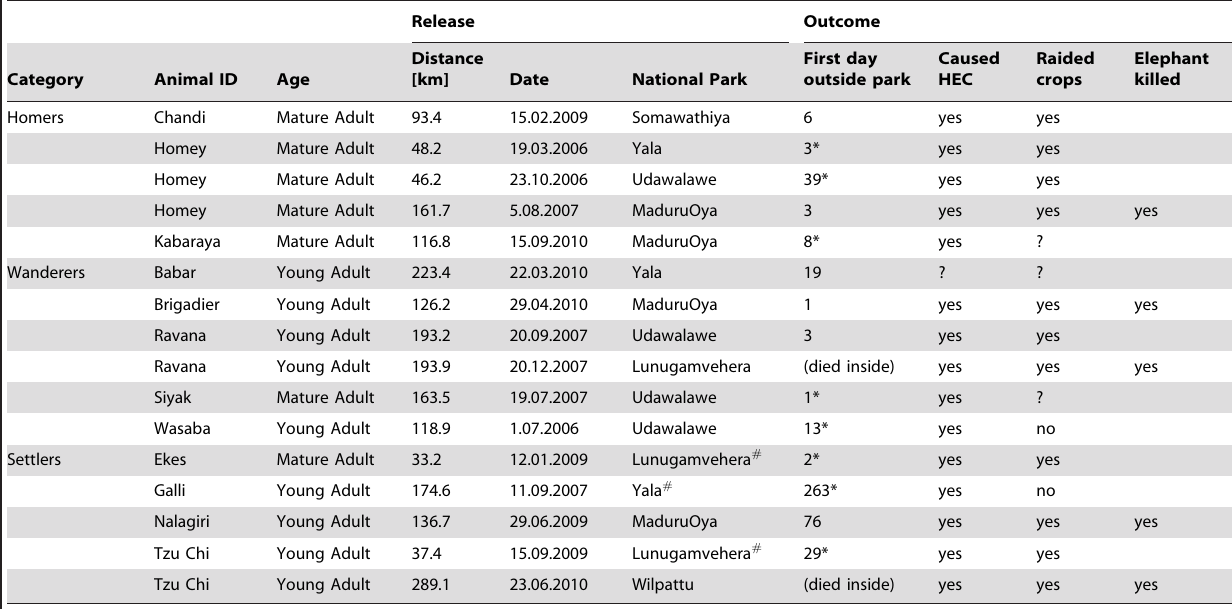
Table 3. Data summary for translocated